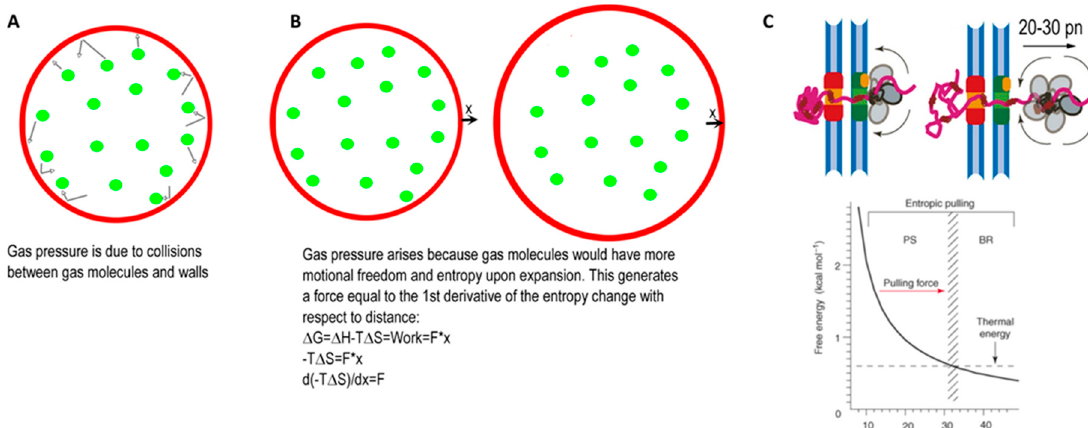
Figure 2. Molecular-kinetic vs. thermodynamic descriptions of gas pressure illuminate the entropic pulling mechanism. ( A ) The molecular-kinetic description of gas pressure ascribes it to collisions between vessel walls and gas molecules. ( B ) The thermodynamic description ascribes it to the entropy increase the gas molecules gain upon expansion. ( C ) Entropic pulling represents a thermodynamic description for how Hsp70s generate force. The force can be estimated as suggested by panel B: by calculating the entropy of the Hsp70 when it is held close to the wall by its peptide tether vs. when it is further from the wall. The decrease in free energy and force follow the curve below the cartoon. Alternatively, we could give a molecular-kinetic description of entropic pulling by pointing out that, when tethered close to the wall, the Hsp70 will frequently collide with and impart a push against the wall, resulting in an equal and opposite push on the Hsp70 which will then pull on the tether. As the Hsp70 moves away from the wall, the frequency of these collisions and the forces will decrease. Panel C adapted from ref [14].